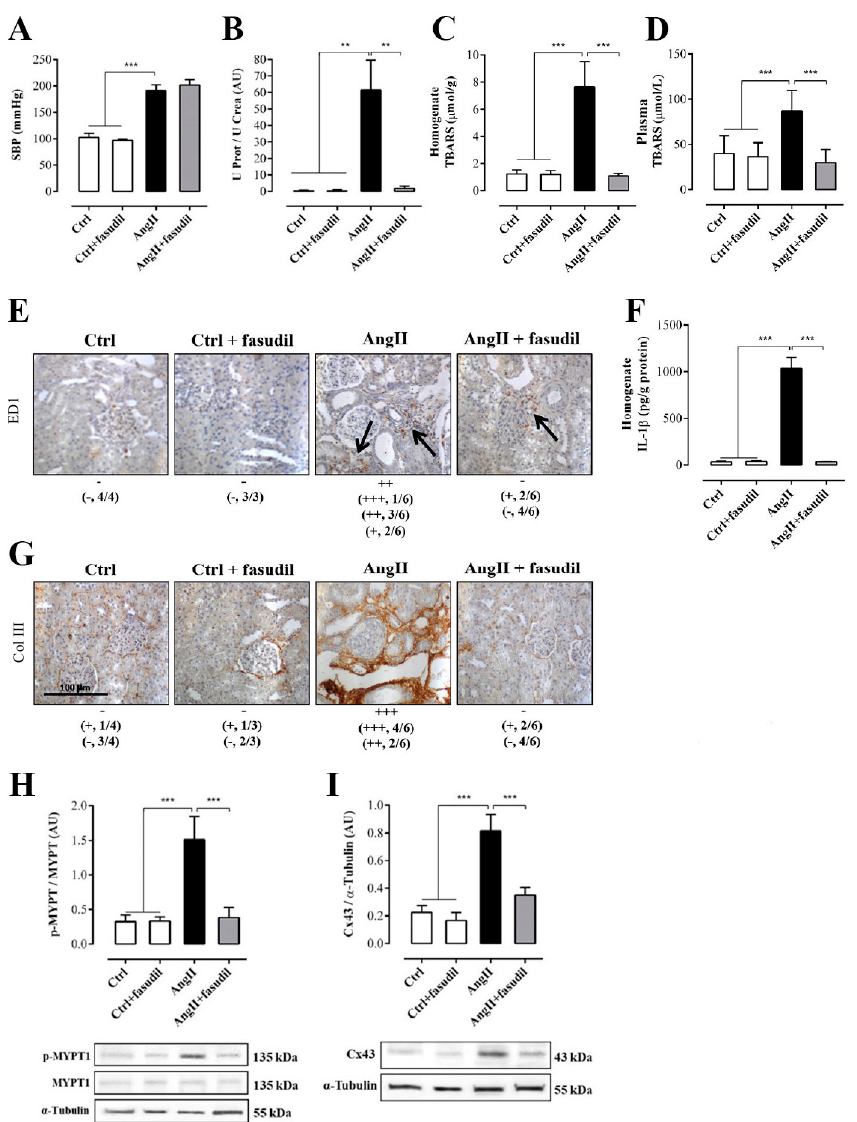
Figure 7. Fasudil prevents kidney damage, OS, inflammation, fibrosis, and the increase in protein amount of Cx43, but does not decrease SBP in rats treated with AngII ( A ). Protein and creatinine were measured in urine samples to assess renal function from ratio UProt / UCrea ( B ). Supernatants of kidney homogenates ( C ) and plasma ( D ) were used to measure TBARS as a marker for the oxidative state. Immunostaining of ED-1 was performed in renal samples ( E ), and kidney homogenates were used to measure levels of IL-1 β as marker for inflammation ( F ). Immunostaining of Col III was performed in renal samples ( G ). Representative pictures of at least three di ff erent kidneys and four di ff erent fields are shown. Scale bar = 100 µ m. Brown staining represents ED-1 and Col III positive immunoreactivity. The semi-quantitative morphometric analysis for ED-1 and Col III was performed as explained in Materials and Methods. Graphs show relative amount of phosphorylated MYPT-1 (p-MYPT) ( H ) and the relative amount of Cx43 ( I ). Under the graph representative pictures of p-MYPT, unphosphorylated MYPT and Cx43 positive bands and its loading control ( α -tubulin) are shown. The bars represent the means ± SE of a n ≥ 4 rats per experimental group. The di ff erences between the subgroups of each of the three groups were evaluated by an ANOVA followed by a Tukey test. *** p < 0.001, ** p < 0.01 and * p < 0.05 vs. AngII group.